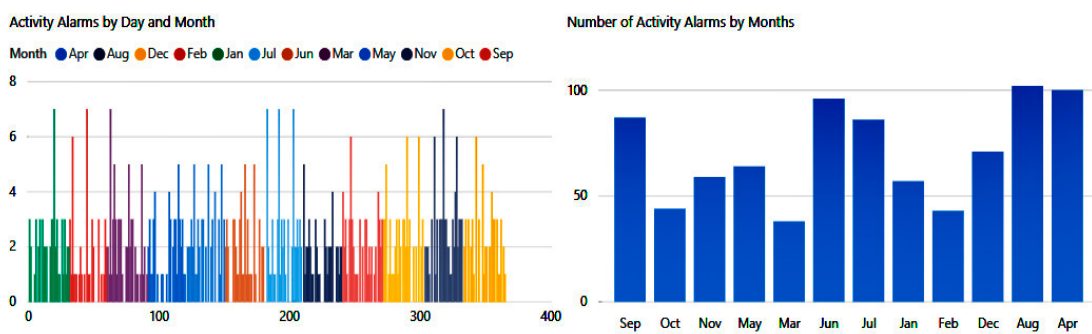
Figure 24. Number of alarms related to activities.